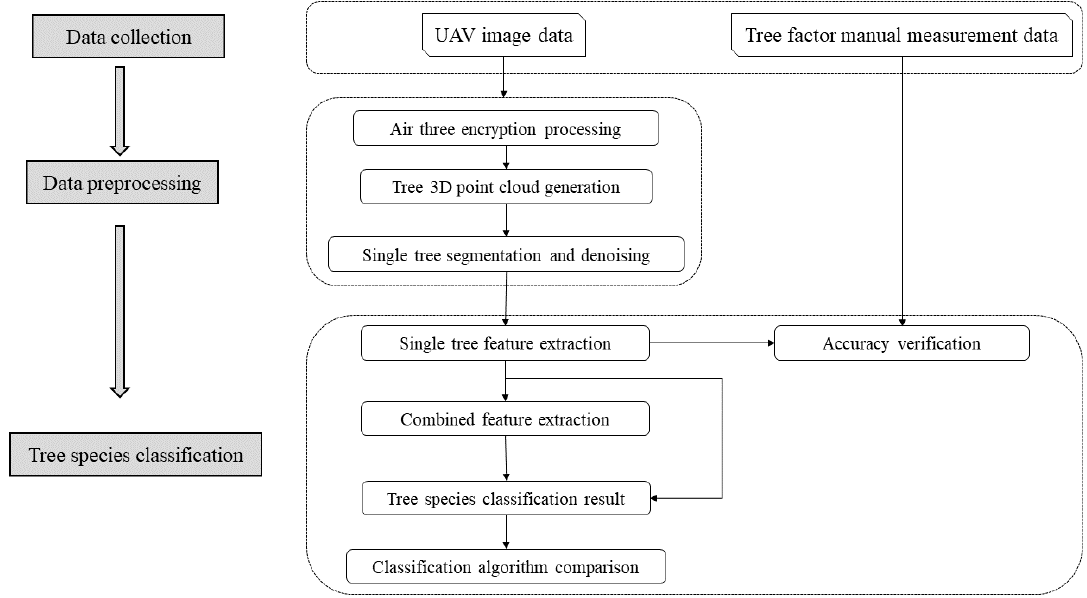
Figure 3. Complete workflow from field data collection to tree species